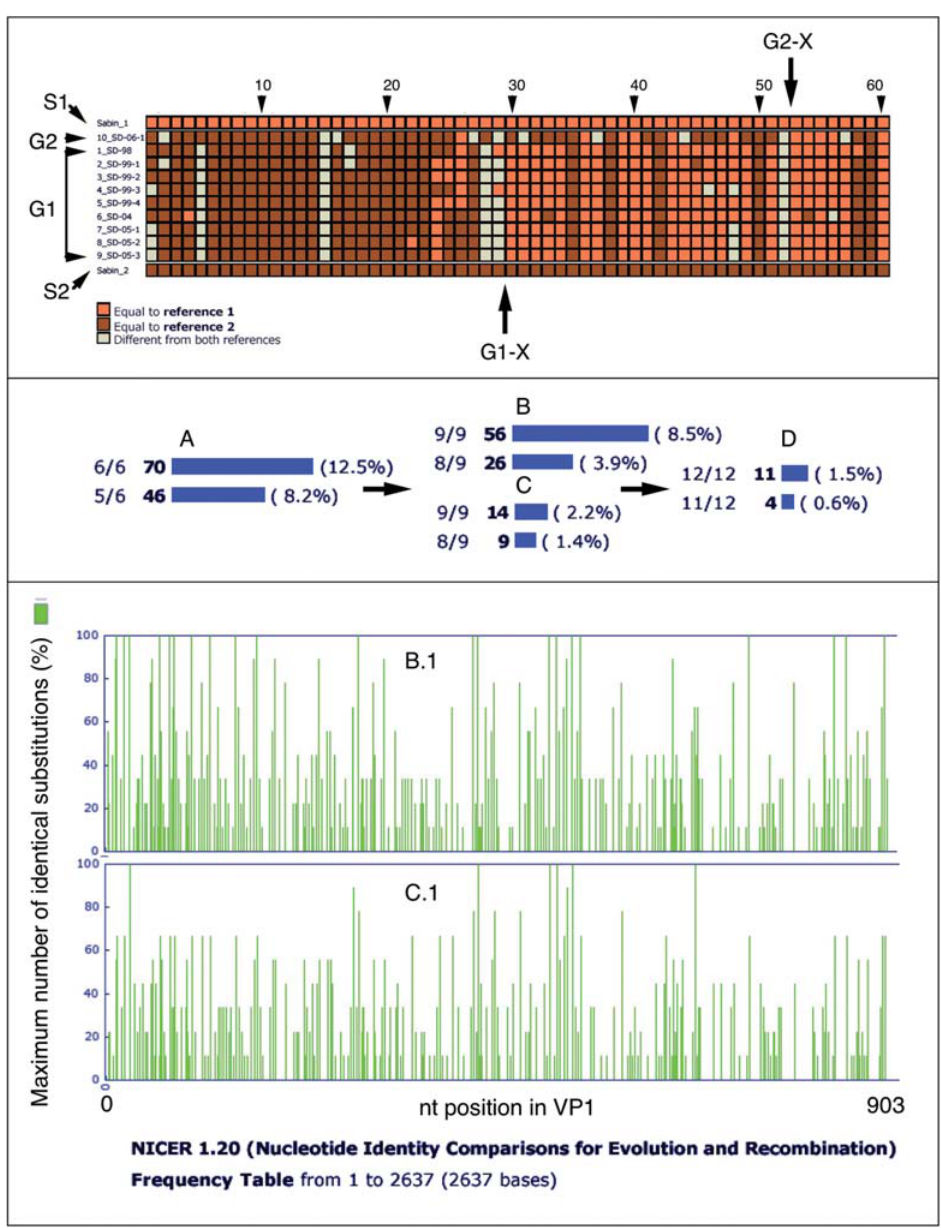
Figure 2. NICER Identity Analysis of the aVDPVs: genomic recombination fingerprint in the 3D polymerase gene, and identity plots for the P1 and VP1 regions. Upper panel: An Identity Plot created by the NICER program of the nucleotide sequences of Group 1 (G1) and Group 2 (G2) aVDPVs compared with Sabin 1 (S1) and Sabin 2 (S2) at each nucleotide position of 3D where Sabin 1 and Sabin 2 differ. The nucleotides of the query sequences are scored as identical to Sabin 1 (light orange/light grey(B&W)) , identical to Sabin 2 (dark brown/dark grey(B&W)) , or different from both (grey/white(B&W)) . The upward pointing arrow (G1-X) , indicating the most likely position where identity of the Group 1 sequences shifts from Sabin 2 to Sabin 1, has been placed between positions 19 and 20 which corresponds to nucleotides 6693 and 6705 of Sabin 2 (Acc: X00595). The downward pointing arrow (G2-X) ; indicating the most likely position where identity of the Group 2 sequences shifts from Sabin 2 to Sabin 1, has been placed between positions 52 and 53 which corresponds to nucleotides 6771 and 6774 of Sabin 2 (Acc: X00595). Middle panel: An Identity Frequency plot to indicate the frequency of occurrence of nucleotide positions in P1 (region R3) of the reference sequence (Sabin 2) where the equivalent nucleotide on at least one of the query sequences differs was created by the NICER program. The number and frequency of identical positions (all of query sequences differ and all have the identical substitution; N/N) and near identical positions (all but one of the query sequences have identical substitutions; N-1/N) is shown for analysis of 6 Group 1 aVDPVs isolated between 1998 and 2004 (A) ; the 6 Group 1 isolates in A plus the 3 Group 1 aVDPVs isolated in 2005 (B) ; the 6 Group 1 isolates in A plus the 3 Group 2 aVDPVs isolated in 2006 (C) ; and all 9 Group 1 and 3 Group 2 isolates (D) is shown. For example; in plot A there were 70 positions where 6 of 6 query sequences had identical substitutions and this identity occurred in 12.5% of all positions where at least one of the query sequences differed from the reference sequence. Bottom panel: An Identity Frequency Distribution plot to indicate the nucleotide position where the equivalent nucleotide on at least one of the query sequences differs from the nucleotide in VP1 (region R4) of the reference sequence (Sabin 2) and % of query sequences that had the maximum number of identical substitutions at each of those positions. Analysis of the 6 Group 1 aVDPV isolates plus either the 3 Group 1 aVDPVs isolated in 2005 (B.1) or the 3 Group 2 aVDPVs isolated in 2006 (C.1) .